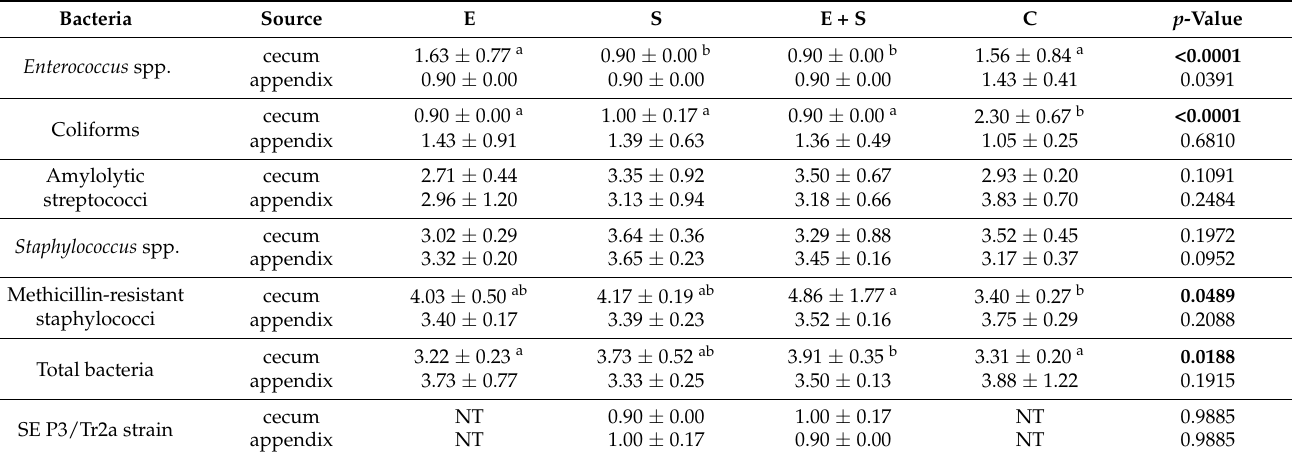
Table 4. Bacterial counts (log 10 CFU/g ± SD) in cecum and appendix of